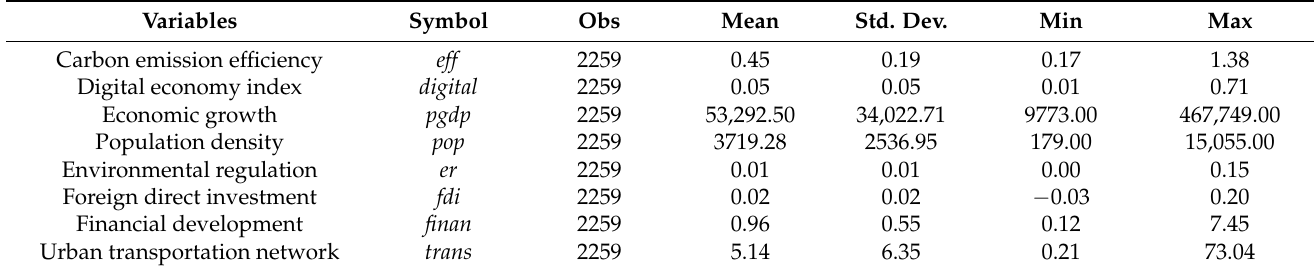
Table 3. Descriptive statistics of the variables (before